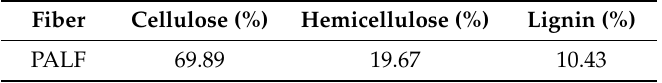
Table 1. Chemical composition of the raw pineapple leaf fiber